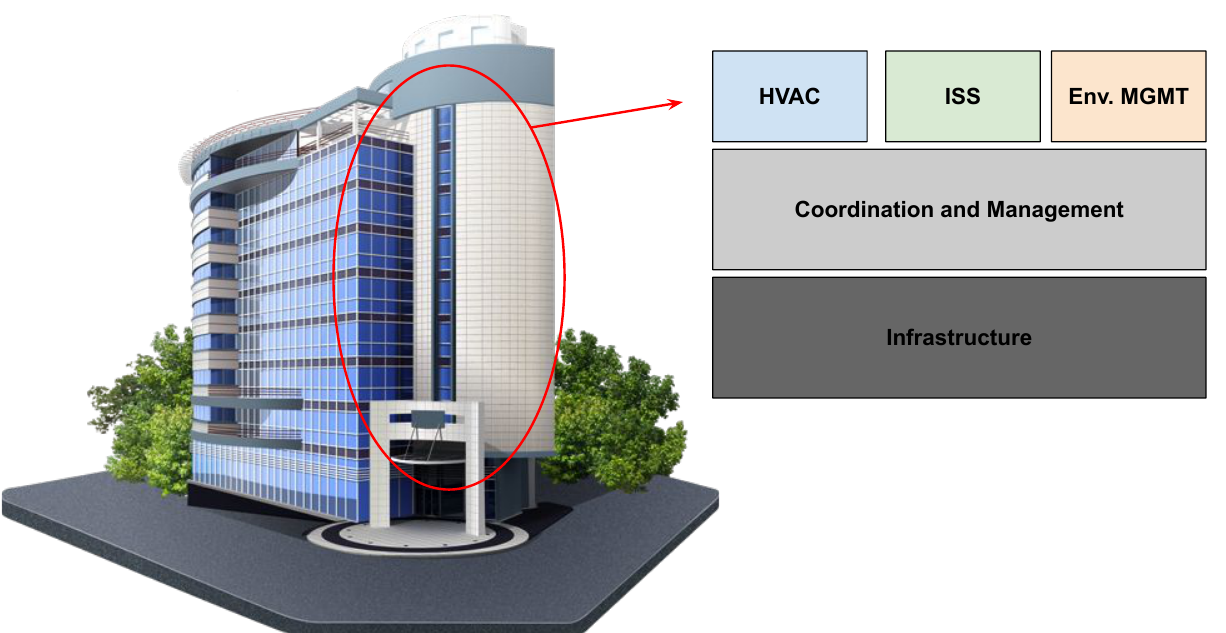
Figure 1. An example of coexistent cyber physical systems (CPSs) in a software-defined